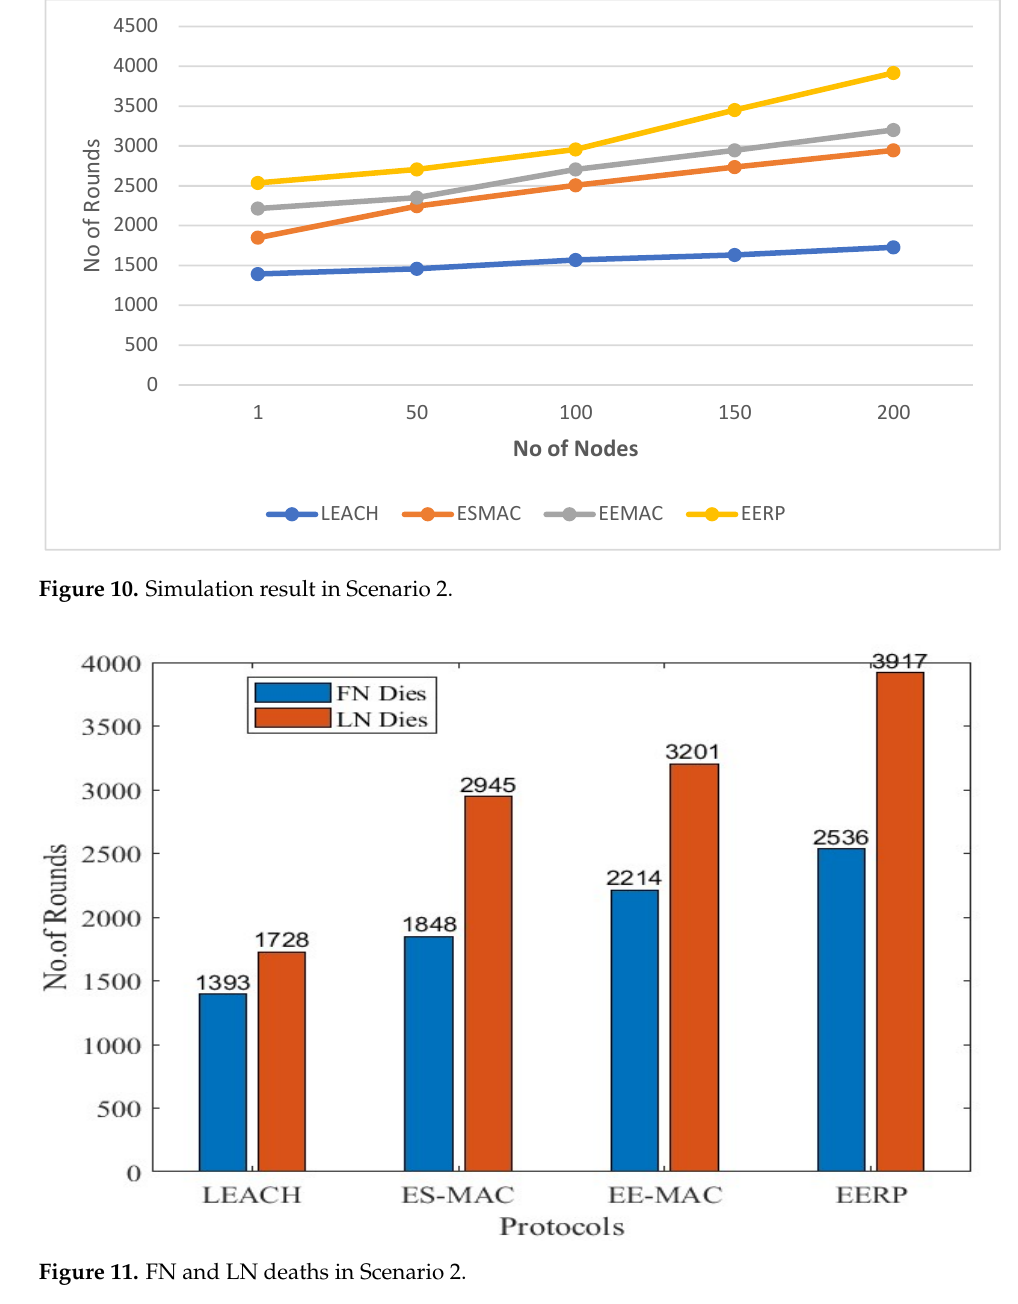
Figure 11. FN and LN deaths in Scenario 2